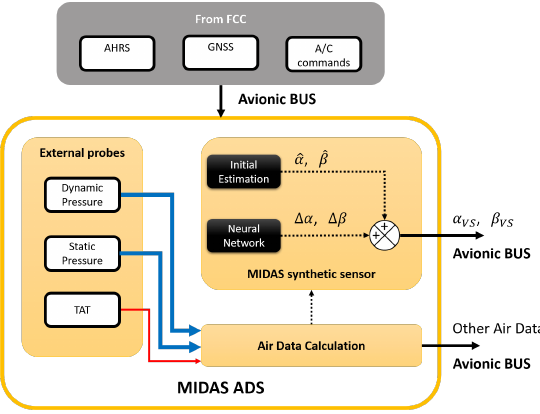
Figure 4. General schematic of the MIDAS